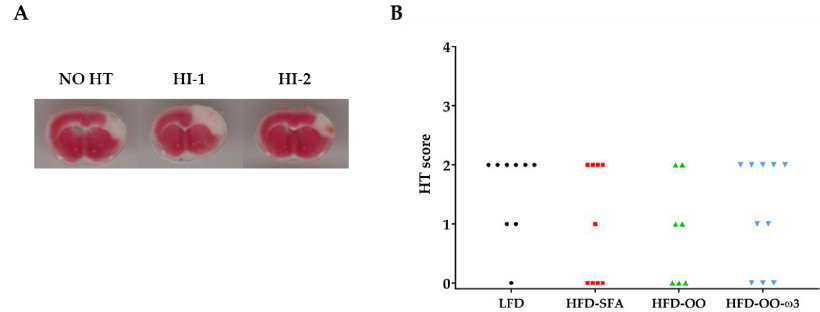
Figure 6. Haemorrhagictransformationanalysis. Groups: LFD(Black), HFD-SFA(Red), HFD-OO(Green), and HFD-OO- ω 3 (Blue). ( A ) Representative images of the classes of macroscopic haemorrhages found during the analysis: no haemorrhages (NO HT), haemorrhagic infarction type 1 (HI-1), haemorrhagic infarction type 2 (HI-2). ( B ) Haemorrhagic transformation score. No significant differences were found between the groups (Kruskal–Wallis + Dunn´s post-hoc). Low-fat diet ( LFD ), high-fat diet rich in saturated fatty acids ( HFD-SFA ), high-fat diet rich in olive oil ( HFD-OO ), and high-fat diet rich in olive oil plus DHA and EPA ( HFD-OO- ω 3